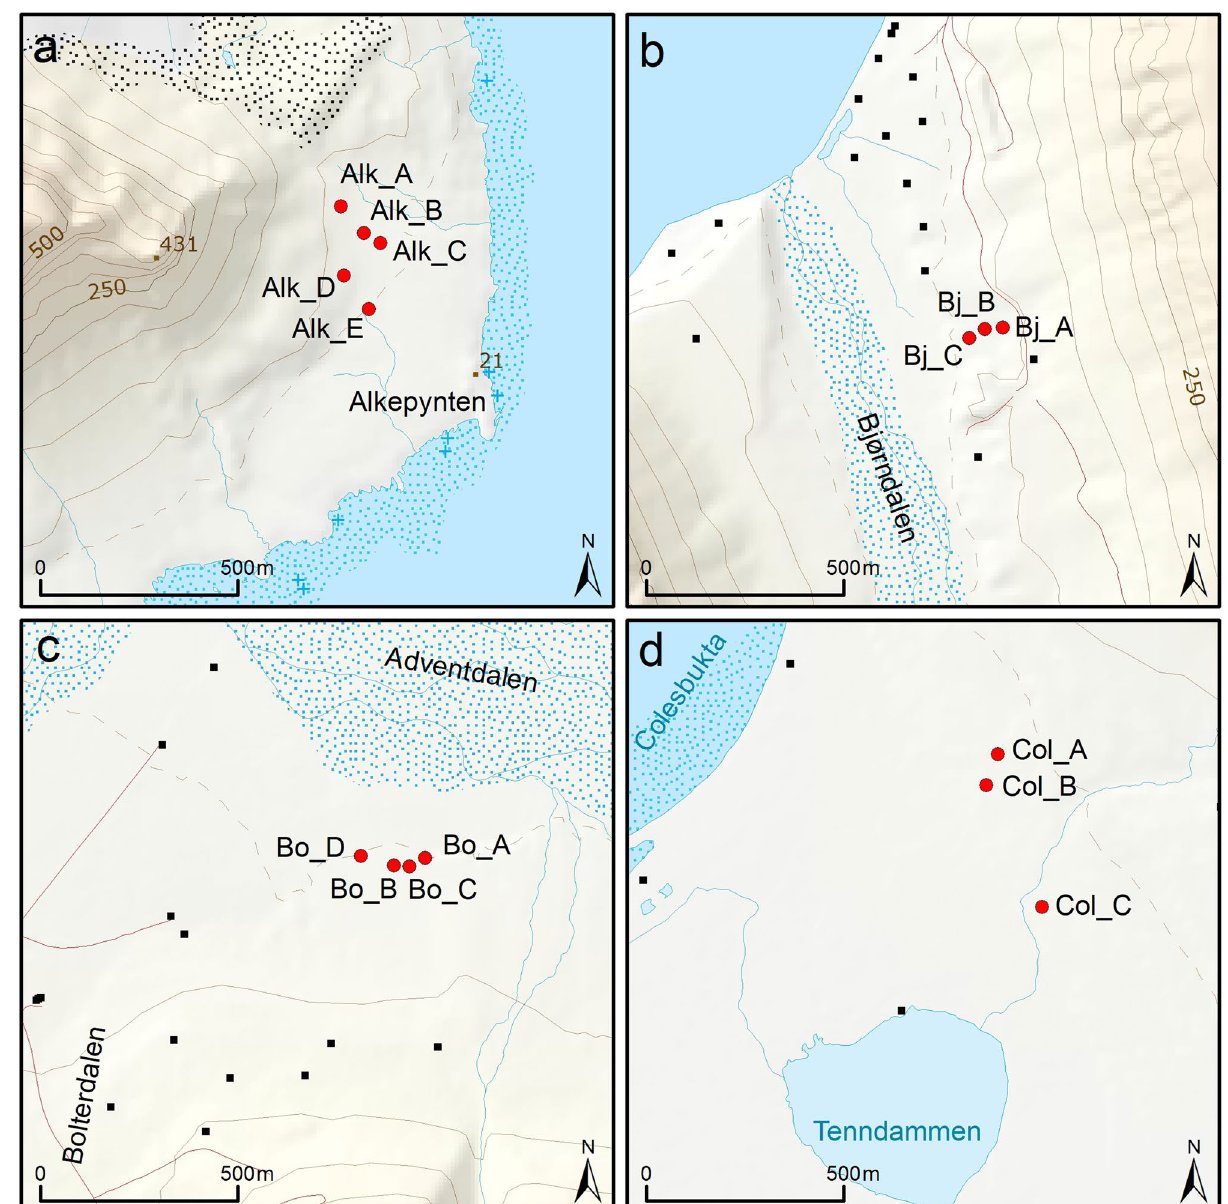
Figure 6. Study points of each study site. (2 a ) Alkhornet, (2 b ) Bjørndalen, (2 c ) Bolterdalen and (2 d )